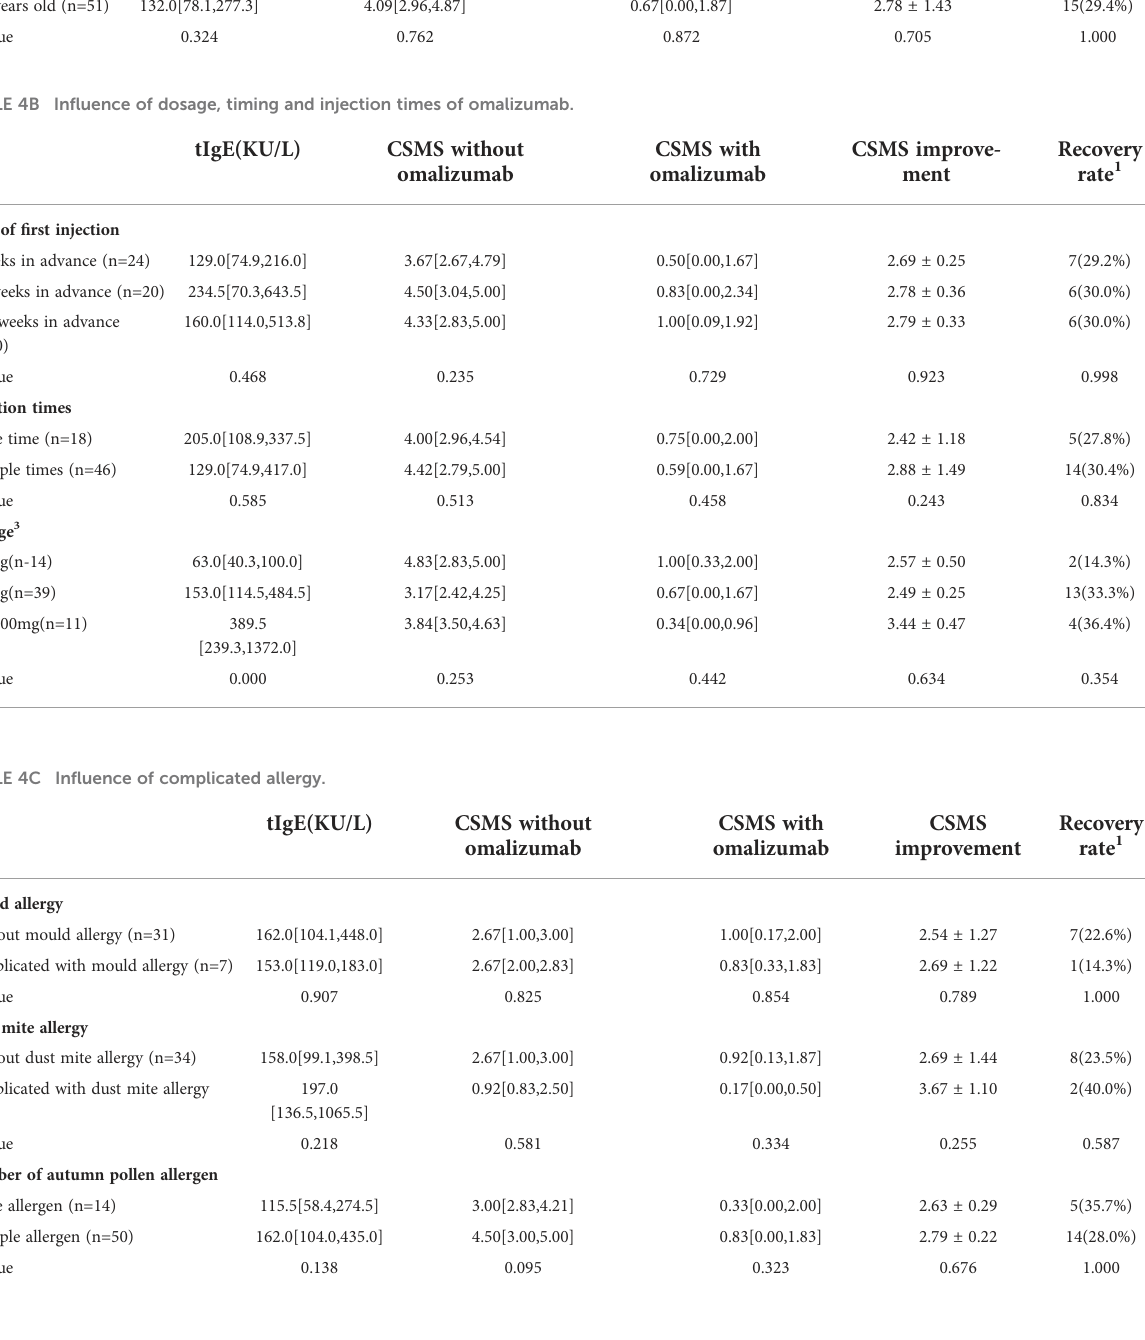
TABLE 4B In fl uence of dosage, timing and injection times of omalizumab.